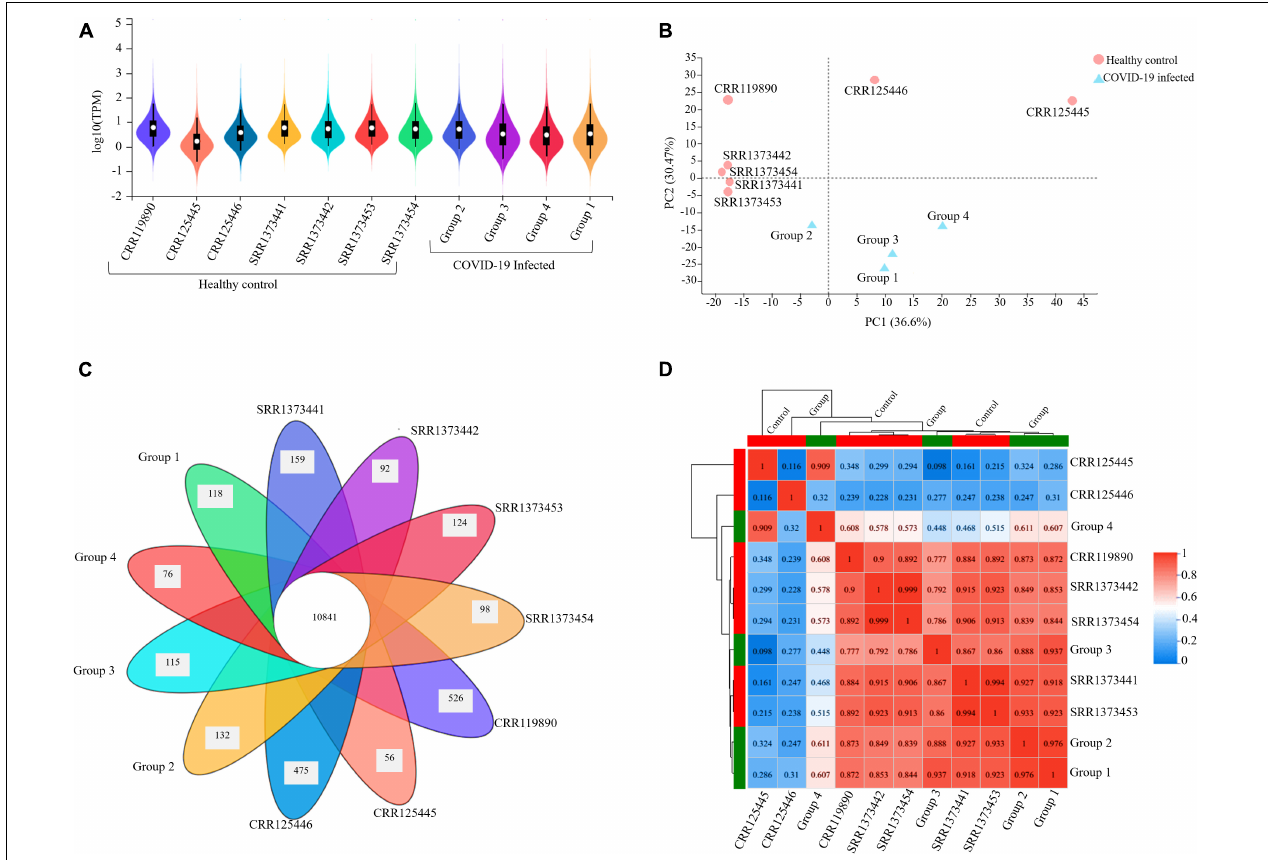
FIGURE 2 | Gene expression quantification and sample correlation of PBMC samples. (A) The violin map illustration of expression distribution in each sample (X-axis) is based on the log10 (TPM) (Y-axis), which is the parametric value of the expression level. (B) PCA (Principal Component Analysis) plot presenting entire samples along PC1 (X-axis) and PC2 (Y-axis), describing 36.6 and 30.4% of the variability within the expression data set. PC analysis practiced normalized (reads per kilobases of transcript per 1 million mapped reads) and log-transformed count data. The closer the distance of each sample, the higher the similarity between the samples. (C) Venn diagram illustrating the number of co-expressed genes among all samples at the intersection (10841) and the number of uniquely expressed genes in each individual that are not part of this common set. (D) Pearson’s correlation matrix visualizes the correlation values between samples with numbered Scale bar representing the range of the correlation